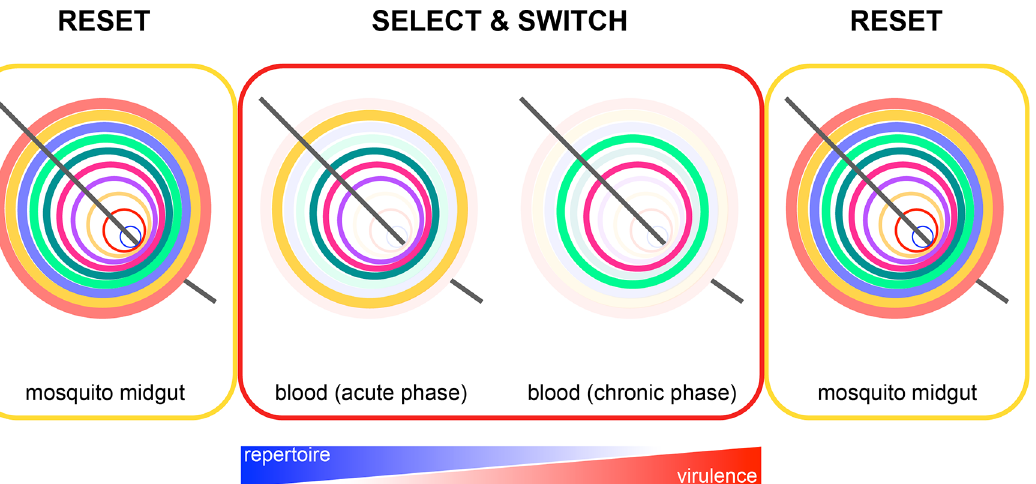
Fig 1. Epigenetic reprogramming of Plasmodium within the mosquito. Reset: expression of subtelomeric multigene families is reset in the mosquito by epigenetic reprogramming of the zygote. This ensures that a parasite population will always express all multigene family members from the start of the erythrocytic cycle and gives merozoites the best possible chance of establishing a blood-stage infection every time they emerge from the liver (e.g., it may be beneficial to express all VSA upon liver egress, as a malaria-experienced host will have pre-existing antibodies that recognise a broad repertoire of variant antigens [23]). Select and switch: parasites that express (or switch to) multigene family members offering a survival advantage in their new host are retained, whereas parasites that silence these genes are lost through rounds of selection. In time, this leads to a parasite population expressing a narrow repertoire of multigene family members that promotes survival and chronicity. The further into the chronic phase of infection, the better adapted are parasites to their host. Plasmodium virulence therefore increases, and the need to reset gene expression also increases. Reset: in preparation for entry into the next host, all chromatin marks are again erased following gamete fusion. This model of gene expression provides a general mechanism by which all Plasmodium subtelomeric multigene families could be regulated by the mosquito.